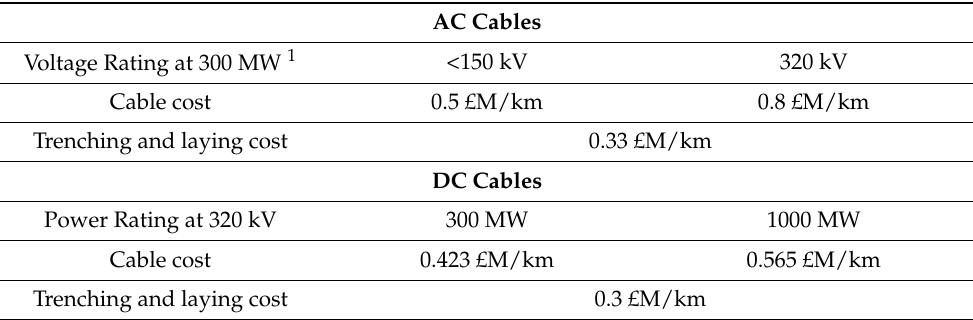
Table 9. Average AC and DC cables’ cost.